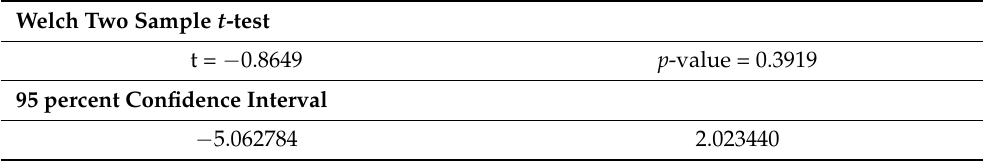
Table 7. Welch Test and Confidence Interval.